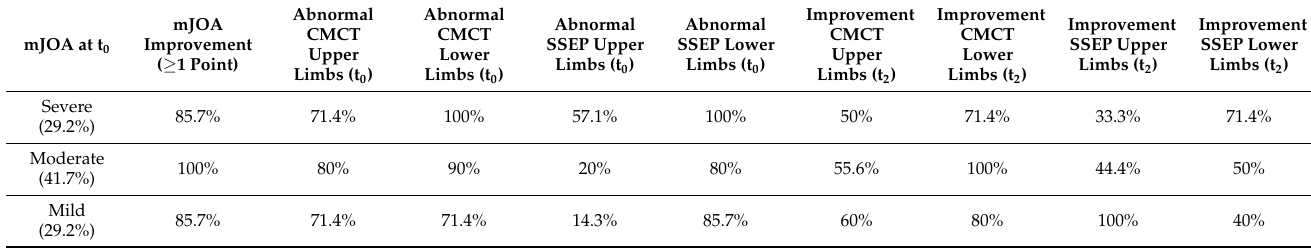
Table 1. Percentage of patients with abnormal TMS and PESS before surgery and changes after surgery according to mJOA grades in upper and lower